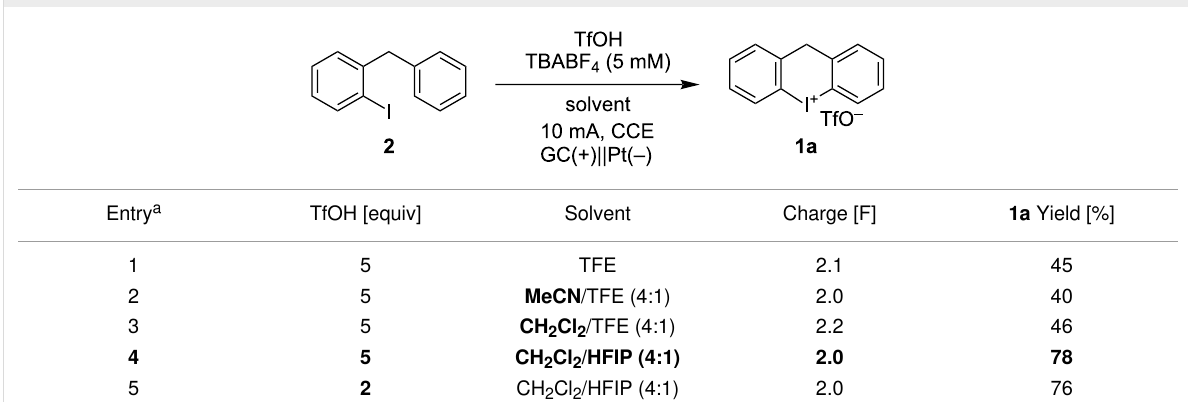
Table 1: Optimization of the oxidation and cyclization in batch.